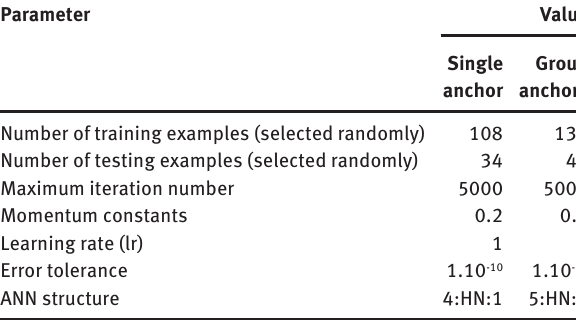
Table 3 The network training